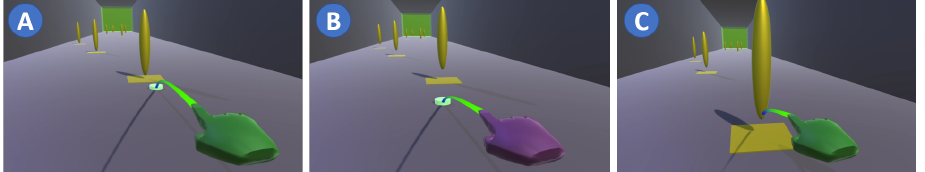
Figure 5. ( A ) Index finger of right hand points to desired position ( B ) Hand is kept still for n = 1.5 s ( C ) User moved to